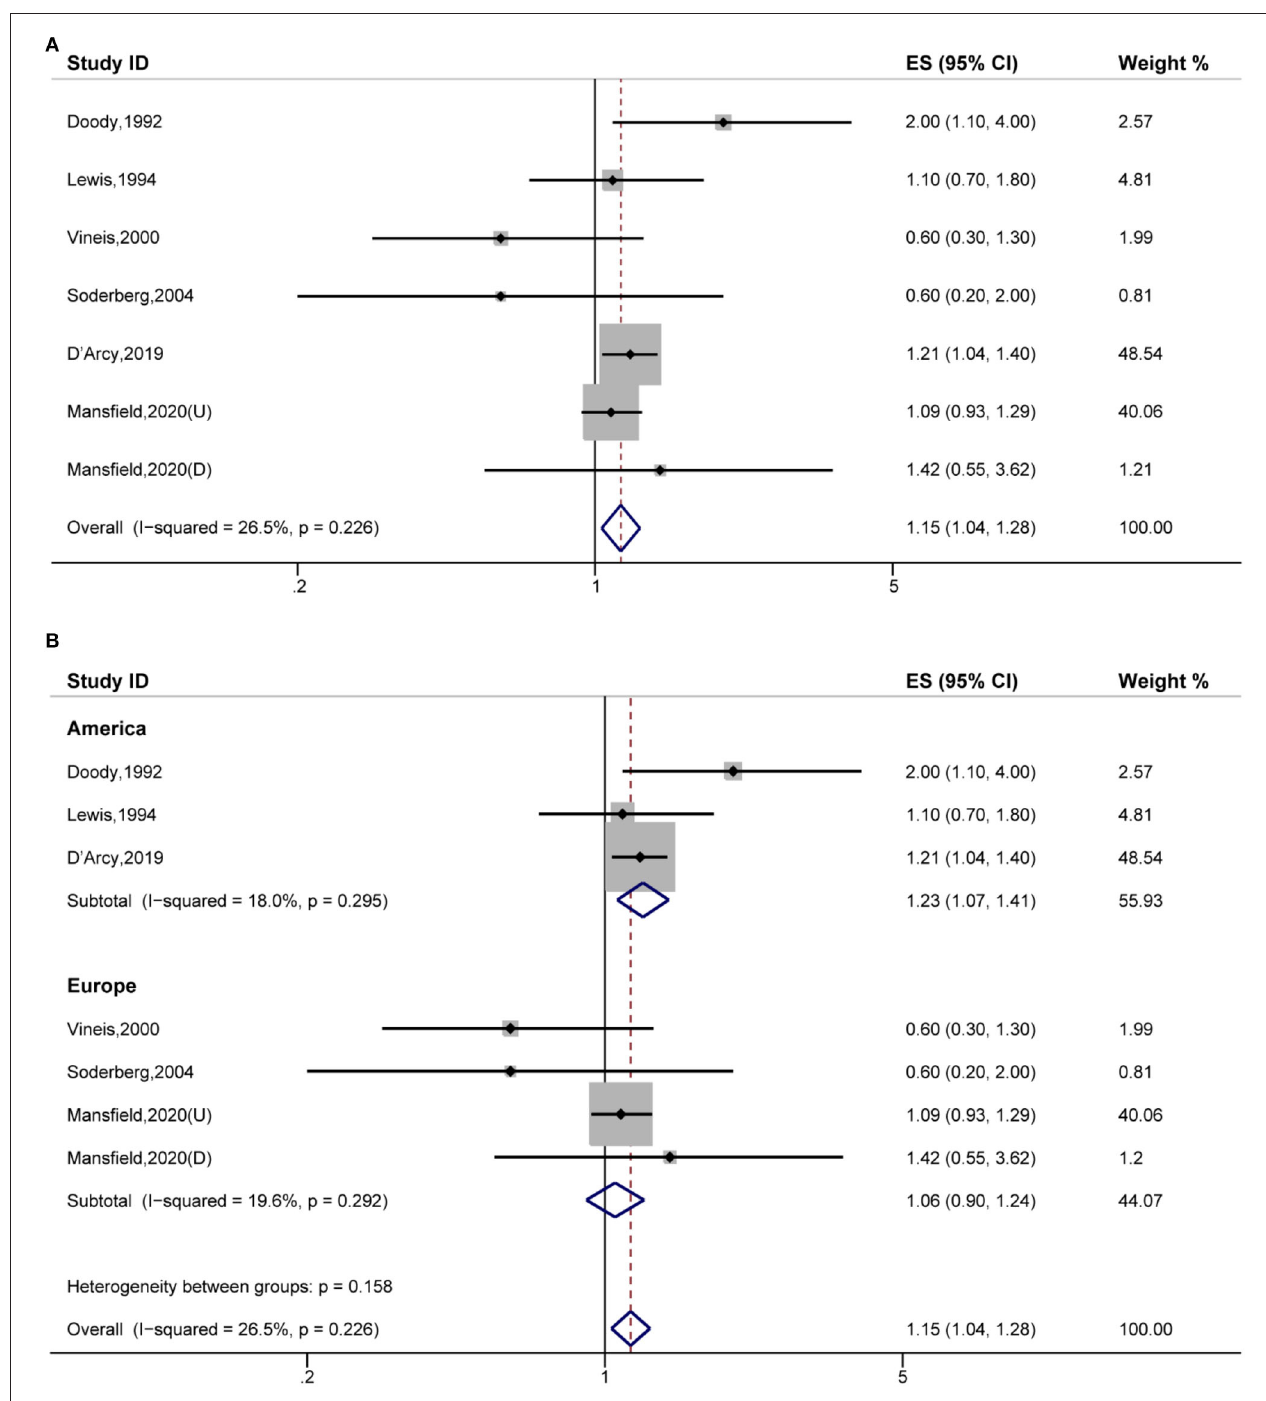
FIGURE 6 | Forest plot of the estimated effects of eczema on myeloma risk. (A) Forest plot. (B) Forest plot for the subgroup analysis by